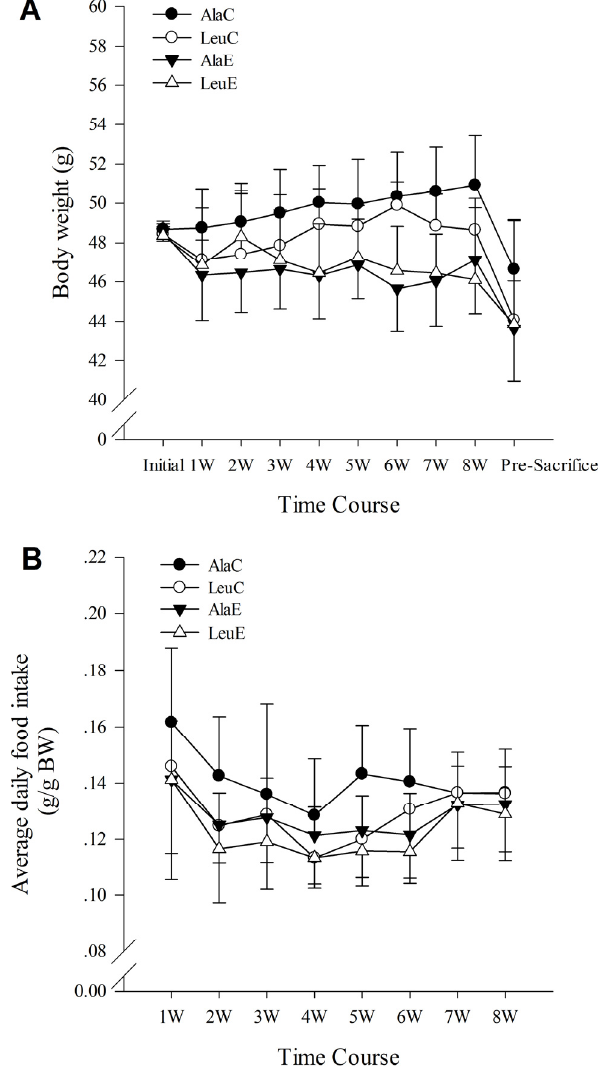
Figure 1. ( A ) Effects of leucine supplementation and exercise on body weight (BW); and ( B ) food intake. AlaC: alanine supplementation group; LeuC: leucine supplementation group; AlaE: alanine supplementation + exercise training group; LeuE: leucine supplementation + exercise training group.